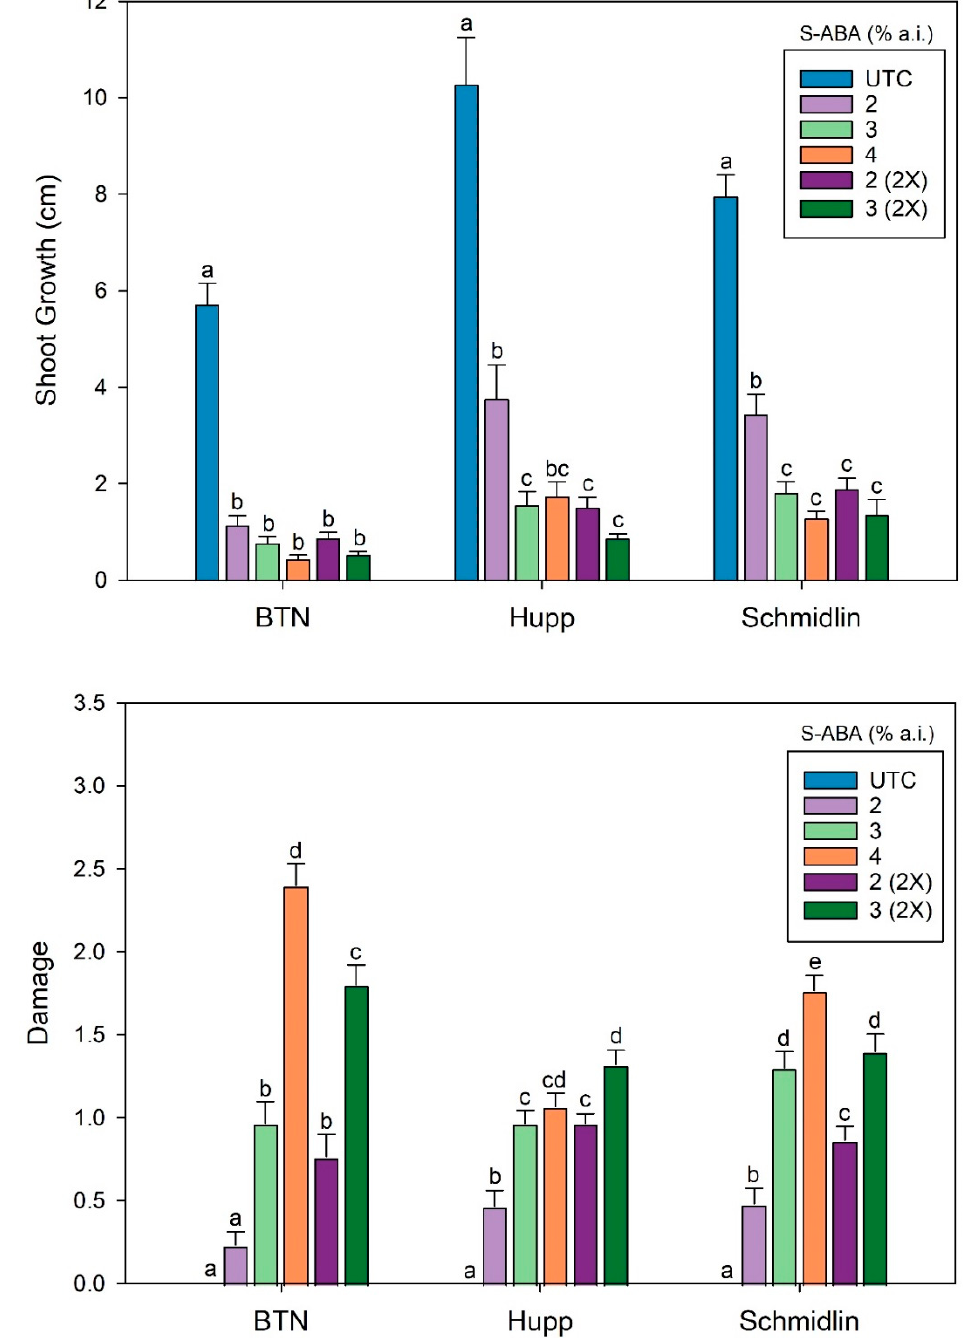
Figure 6. Mean shoot growth ( top ) and damage rating ( bottom ) of leaders of noble fir trees at three farms treated in 2020 with S-ABA applied once or as a repeated application (2×). S-ABA concentration is in % a.i. NOTE: Error bars indicate standard error of the mean. Means within a farm indicated by the same letter are not different at p = 0.05. Mean separation by Tukey’s HSD test. Damage rating (0 = no phytotoxicity; 4 = severe phytotoxic damage).